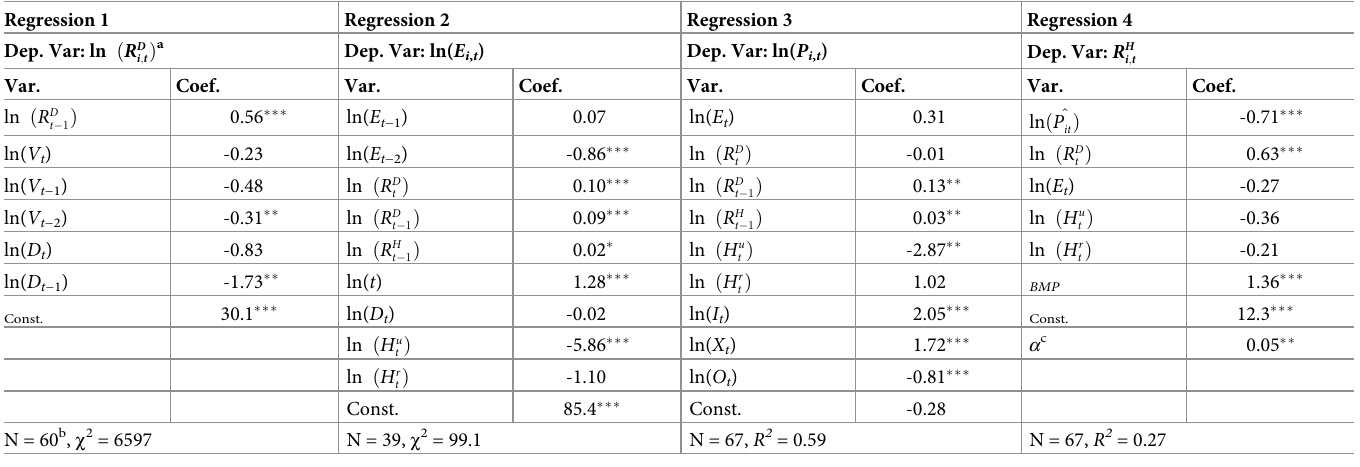
a Statistics in this table represent the sample used in Regressions (3) and (4) reported in Table 3, which have the largest sample sizes.